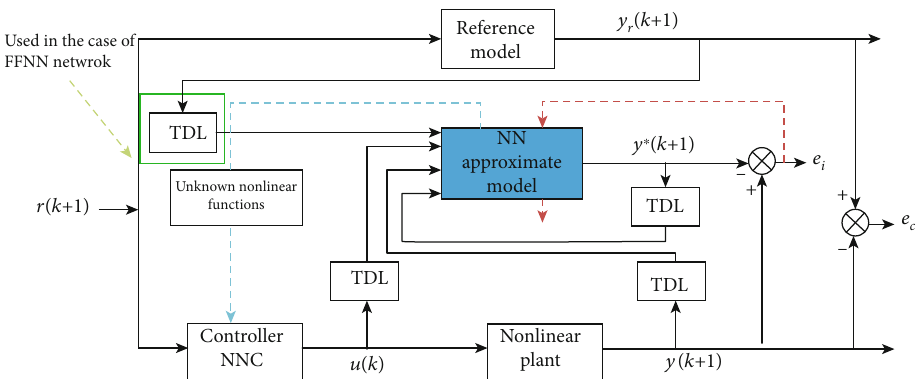
Figure 4: Adaptive control using neural network approximate models.